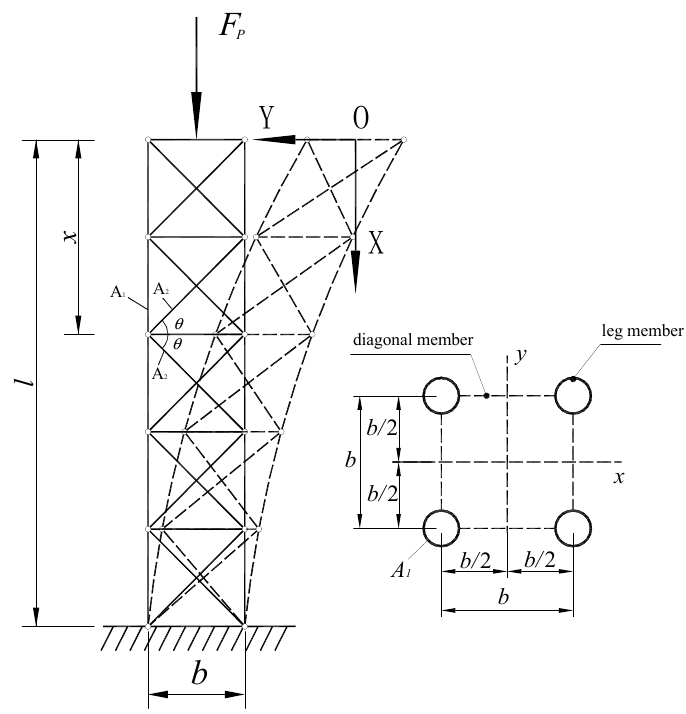
Figure 10. Theoretical calculation model of cantilever tower.